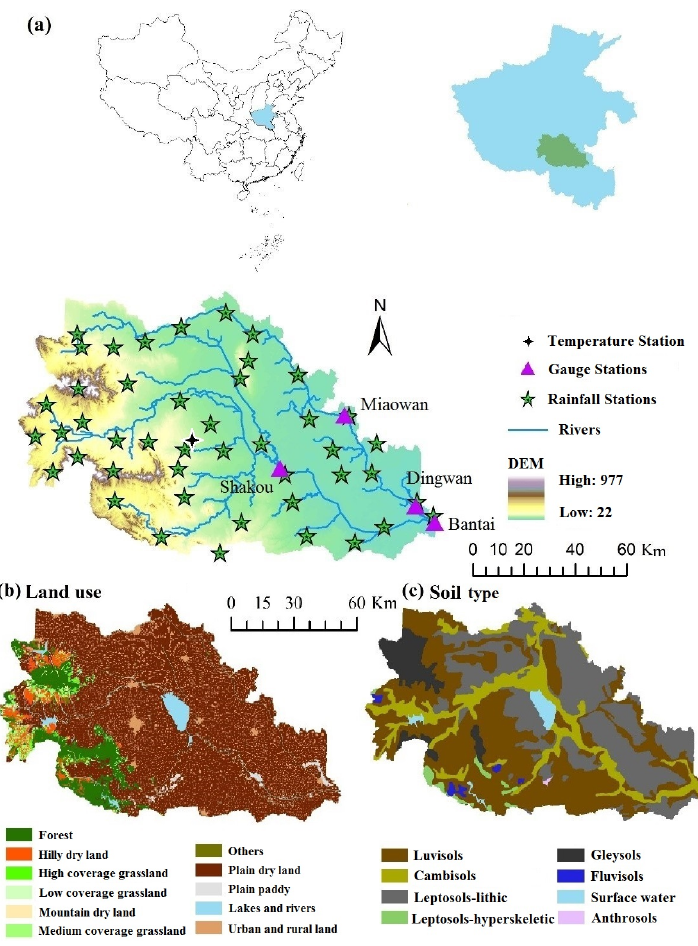
Figure 1. ( a ) Hong–Ru River Basin DEM and its location; ( b ) land use; and ( c ) soil type. Forty-five precipitation gauging stations were selected and relatively equally distributed. In this regard, the whole river basin can be reasonably monitored. The ungauged precipitations of some sub-basins were substituted by the nearby recorded rainfall. The sub-basin distributions are illustrated at Part 3.3.3 to enhance the understanding of the annual yields of TN and TP load simulations in each sub-basin. The mean annual precipitation in the whole catchment is 934 mm. The amount of precipitation in summer is higher than that in winter. The mean temperature is 15.7 °C, as indicated by the temperatures of all sub-basins from the same meteorological data in Zhumadian City Meteorological Bureau. Temperatures at >30 °C are detected in June, July, and August; the